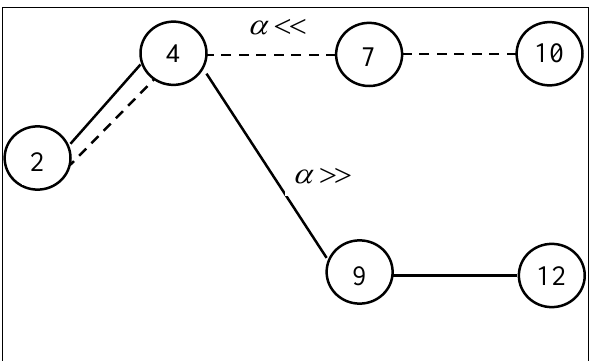
Fig 2. S Optimal network structure of SC in respect to alpha